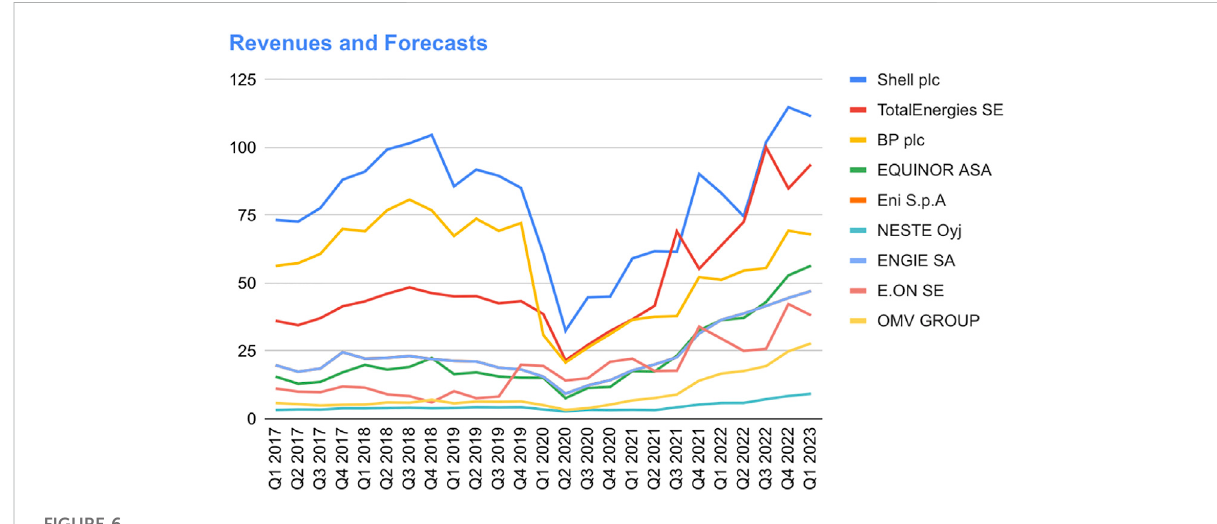
FIGURE 6 Line chart: forecasts and revenues. Source: Own elaboration.